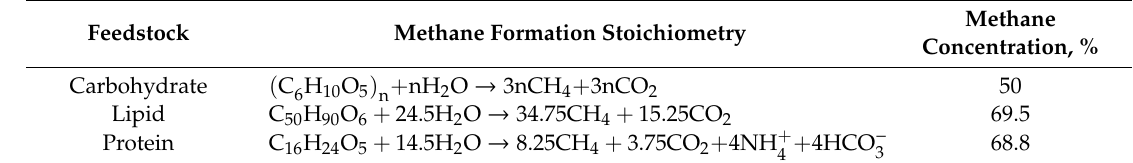
Table 2. Stoichiometry of biogas potential determination from various feedstock components [25]. Feedstock Methane Formation